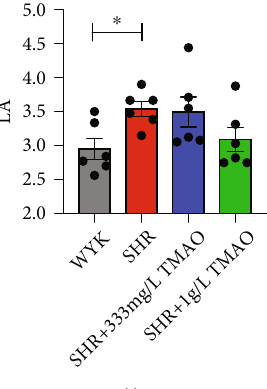
Figure 3: E ff ect of gut microbial-related choline metabolite TMAO on hemodynamic and cardiac parameters. The echocardiography pictures of 30-week-old WKY rats, SHR treated with water, and SHR treated with 333 mg/L and 1g/L TMAO in drinking water for 22 weeks are shown in Figures 3(a) – 3(d). Variation in (e) LVOT (left ventricular out fl ow tract), (f) AoRoot (aortic root), (g) LVAWd (left ventricle anterior wall thickness in diastole), (h) LVAWs (left ventricle anterior wall thickness in systole), and (i) left atrial dimension (LA) in each group. Results are mean ± SD . ∗ p < 0 : 05 ; ∗∗ p < 0 : 01 ; ∗∗∗ p < 0 : 0005 ; ∗∗∗∗ p < 0 : 0001 . Grey bars represent Wistar-Kyoto (WKY) rats ( n = 6 ); red bars represent spontaneously hypertensive rats (SHRs) treated with water ( n = 6 ); blue bars and green bars represent SHRs treated with water containing 333 mg/L ( n = 6 ) and 1g/L TMAO ( n = 6 ),